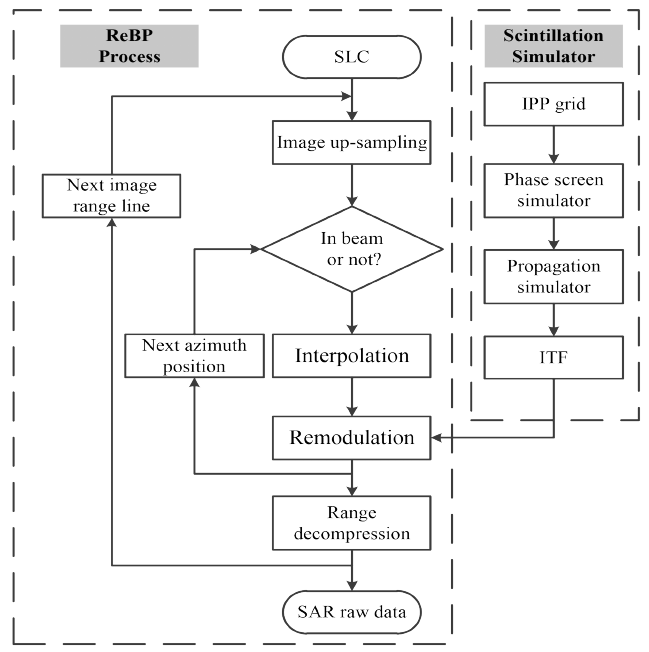
Figure 9. The block diagram of the ReBP–based